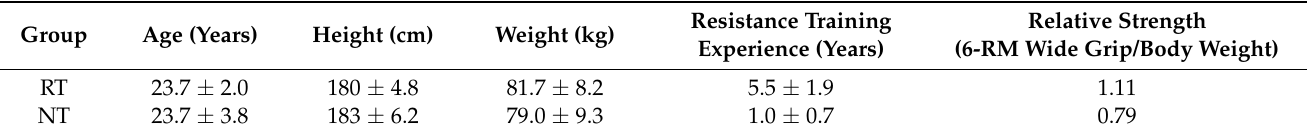
Table 1. The anthropometric of the subjects (mean ± standard